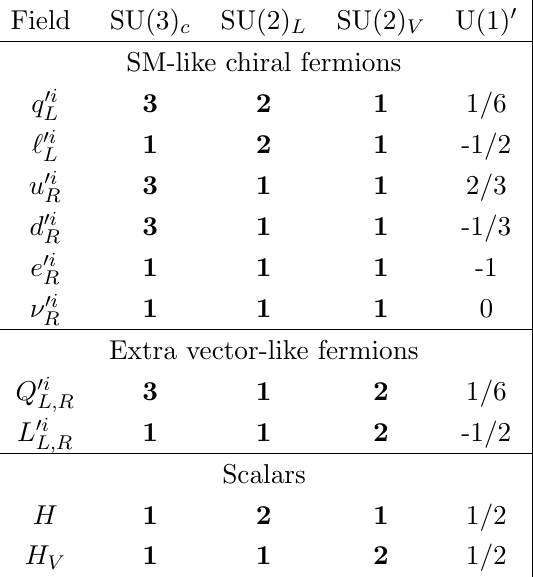
Table 1 . Matter content of the model in the unbroken phase of gauge group G . The (cid:13)avour index i 2 f 1 ; 2 ; 3 g . Singlet representation is denoted with 1 , while fundamental of SU(3) (SU(2)) is 3 ( 2 ). The last column shows the Y 0 quantum